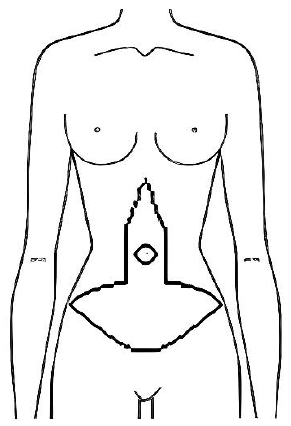
Figure 1. Preoperative drawing of fleur de lys abdominoplasty.